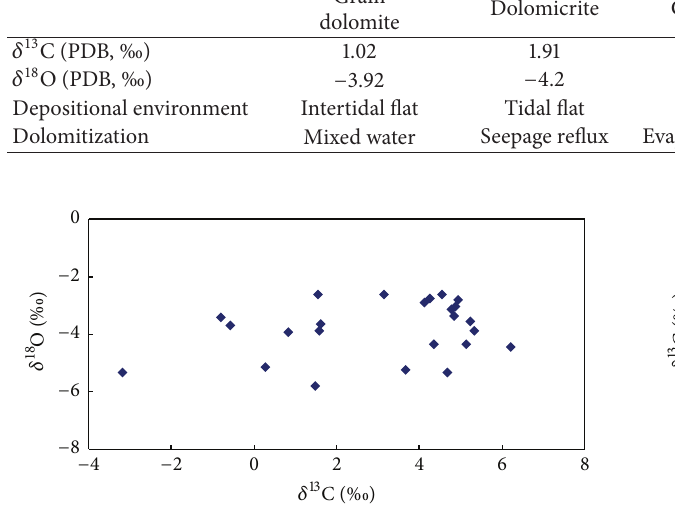
Figure 12: Relationship between carbon isotope and